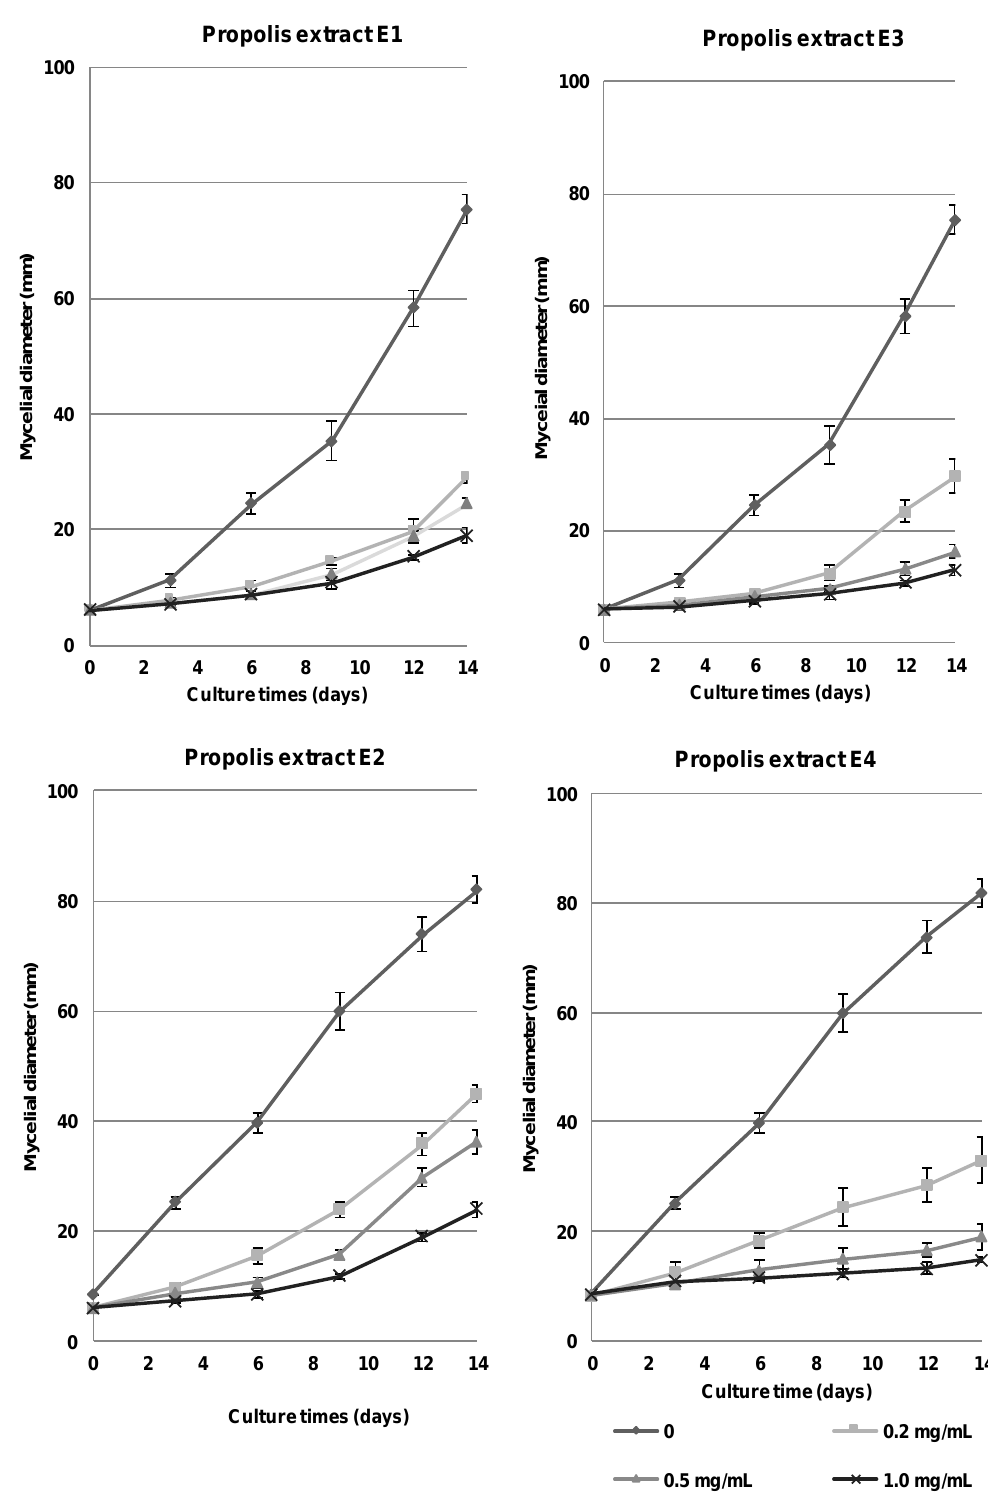
Figure 1. In vitro S. vesicarium mycelial growth in potato dextrose agar (PDA) medium without propolis (0 mg/mL) and with different concentrations (0.2, 0.5, and 1.0 mg/mL) of propolis extracts (E1, E2, E3, and E4), after 14 days of incubation at 25 °C. Data presented are means ± standard deviation of three replicates.